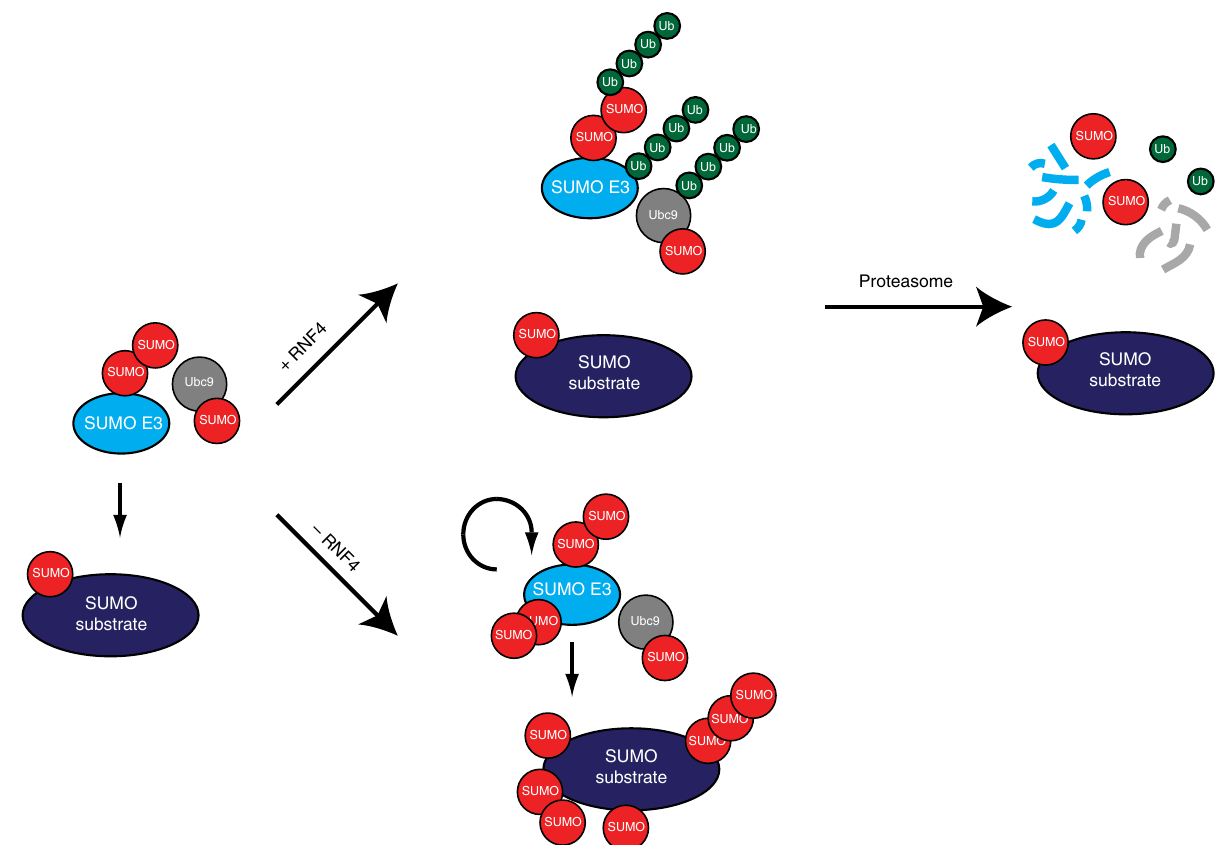
Fig. 10 Model explaining the rise and fall of SUMOylation at sites of DNA damage. SUMO E3 ligases are recruited to sites of DNA damage, to modify repair factors including BARD1. Subsequently, the STUbL RNF4 is recruited to ubiquitylate SUMOylated proteins including autoSUMOylated SUMO E3 ligases and autoSUMOylated Ubc9. These proteins are subsequently degraded by the proteasome to resolve the SUMOylation signal at the site of DNA damage, explaining the transient nature of the